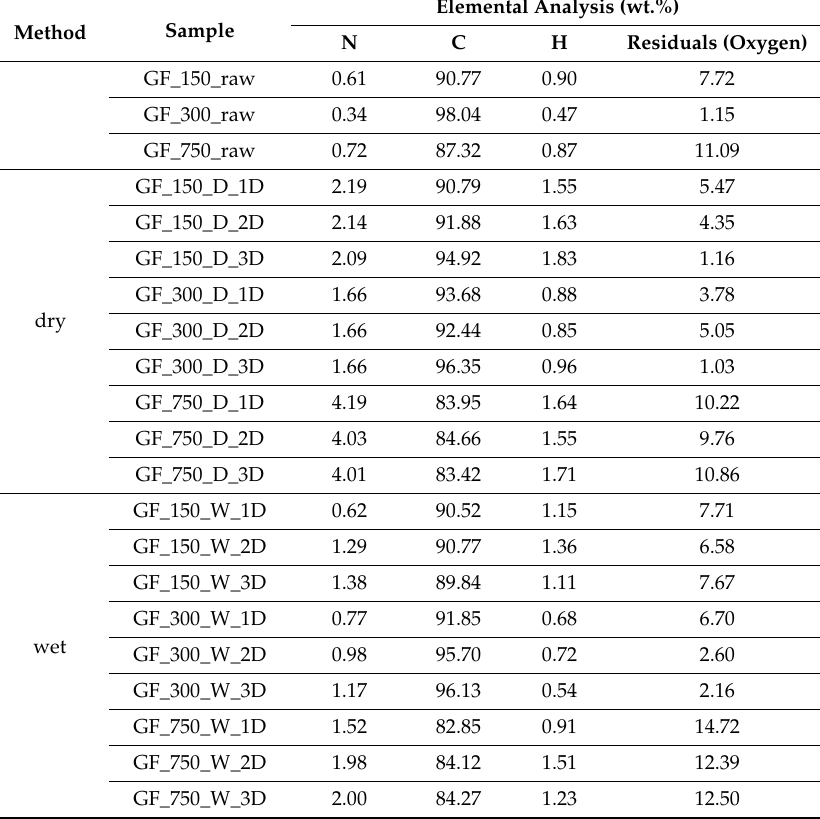
Table 3. Elemental composition of obtained N-doped